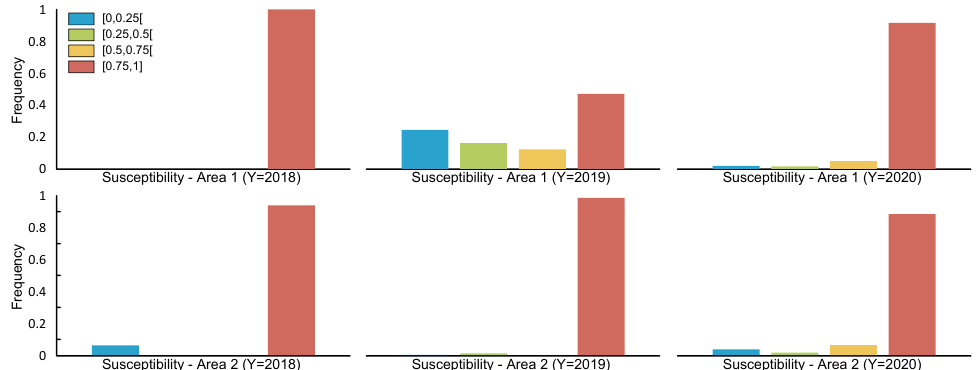
Figure 11. Observed susceptibility values w.r.t. the fire-affected areas in the reference dataset for each study area and epoch with IF method as anomaly detection model.